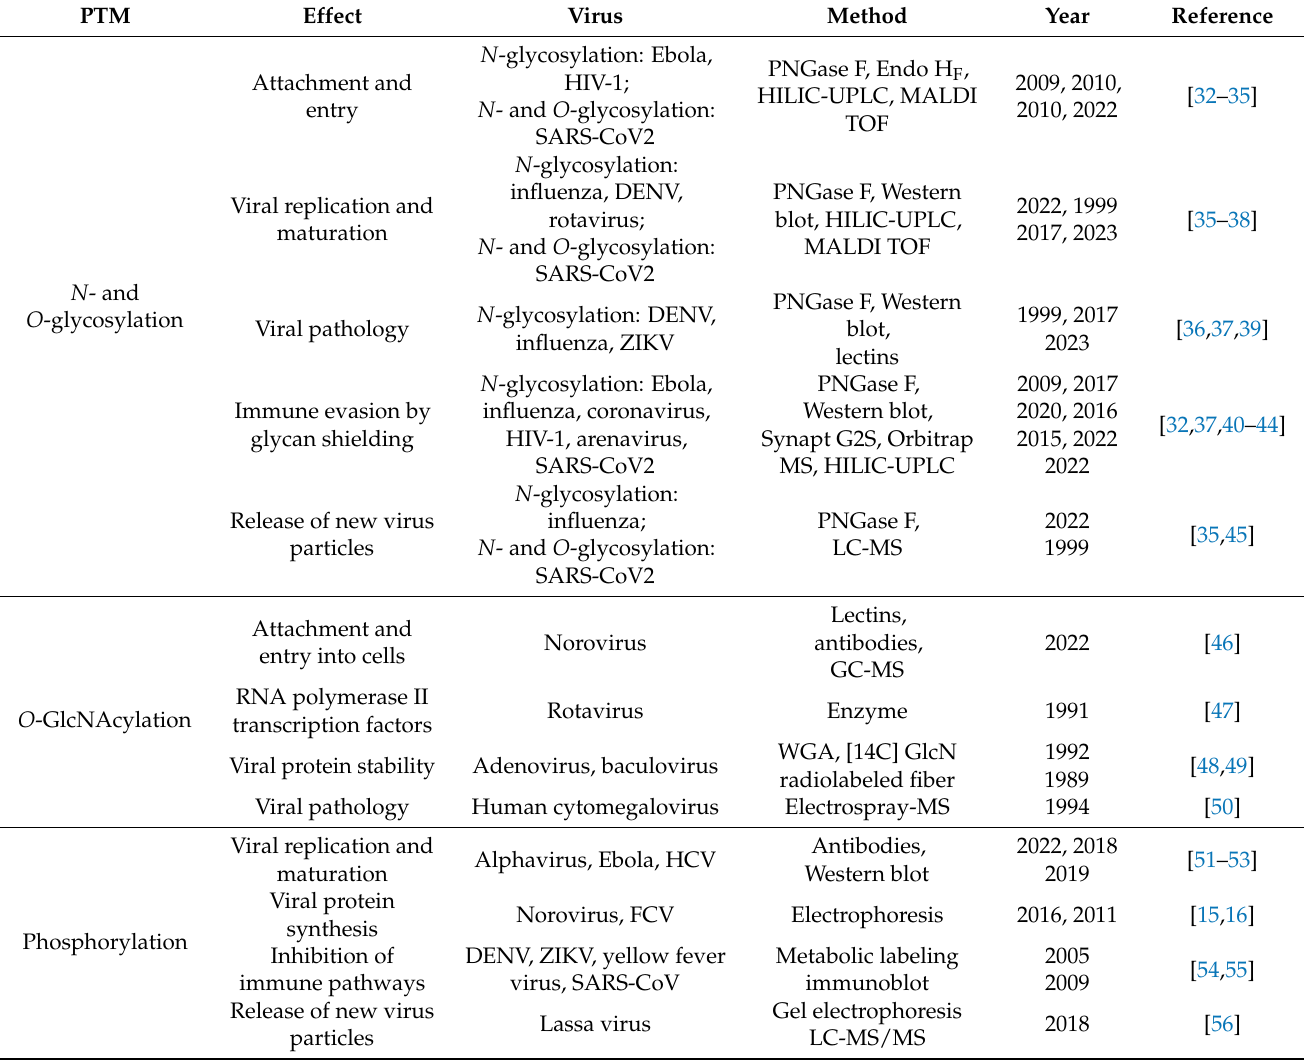
Table 1. Established roles of N - and O -glycosylation, O -GlcNAcylation, and phosphorylation in viral